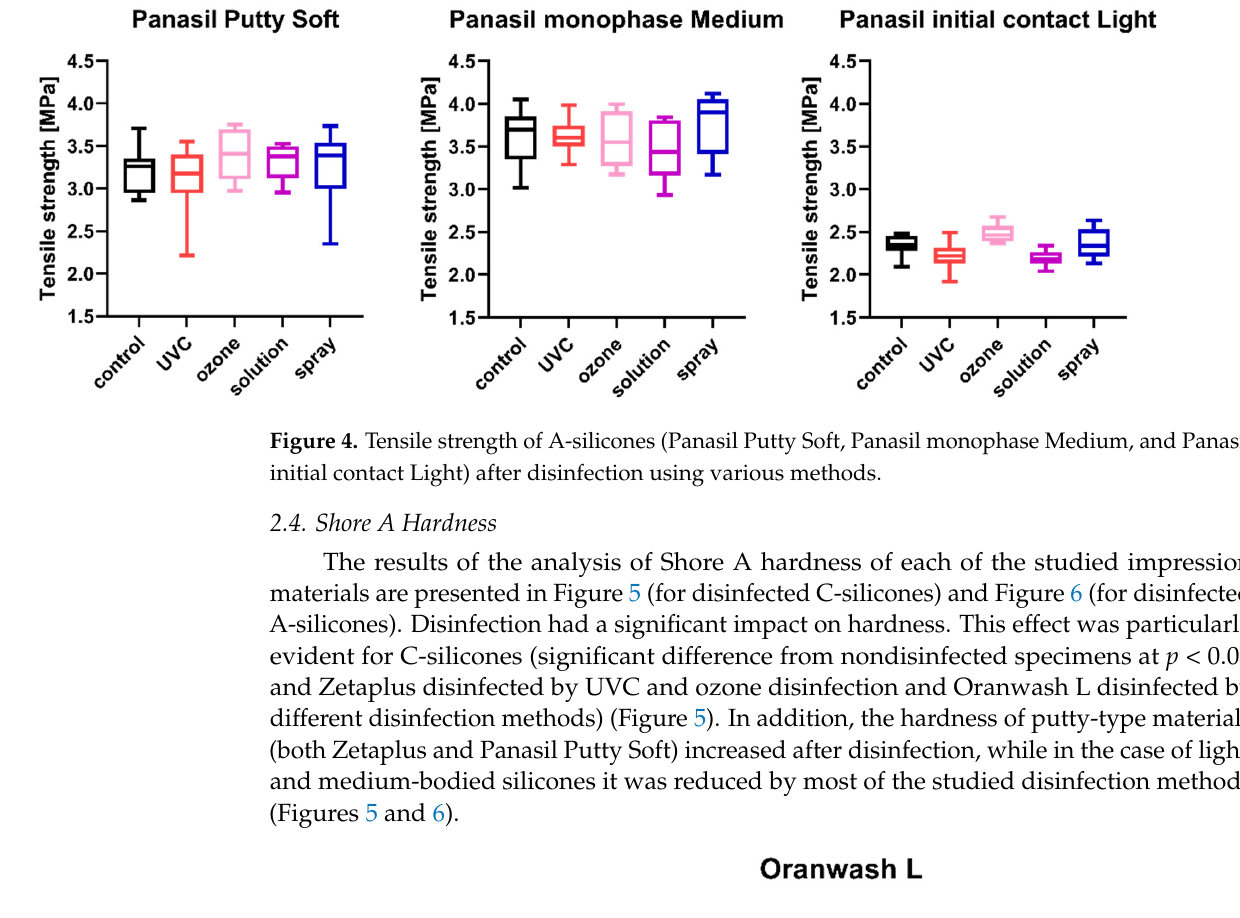
Figure 3. Tensile strength of C-silicones (Zetaplus Putty and Oranwash L) after disinfection using various methods.